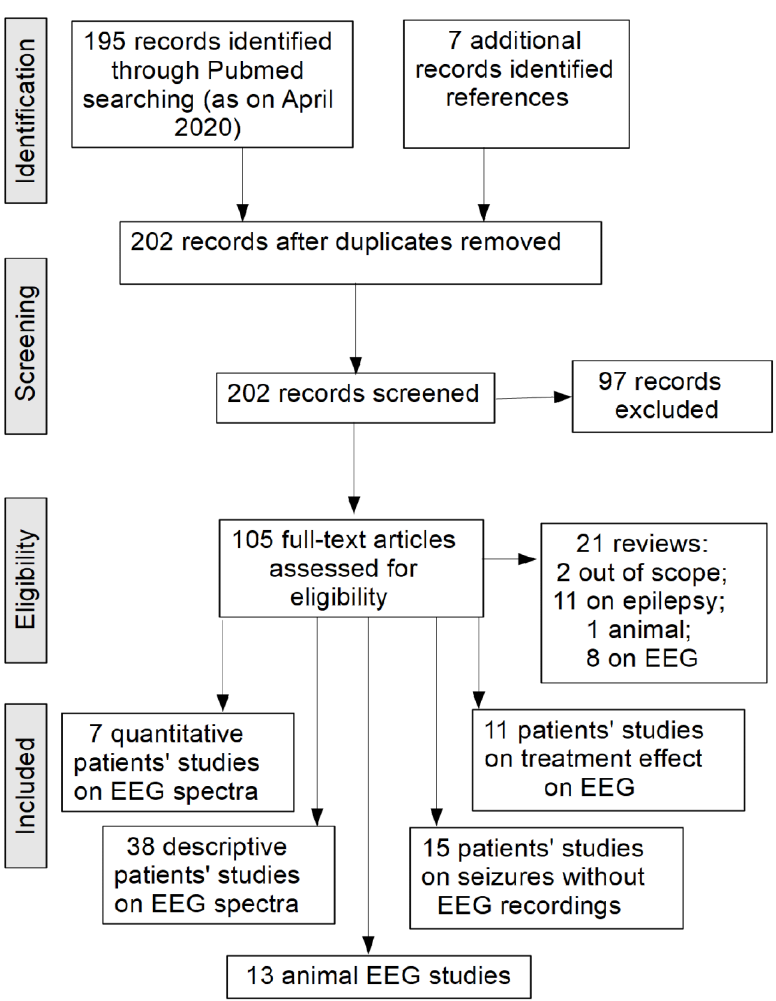
Figure 4. PRISMA Figure 4. PRISMA flowchart.